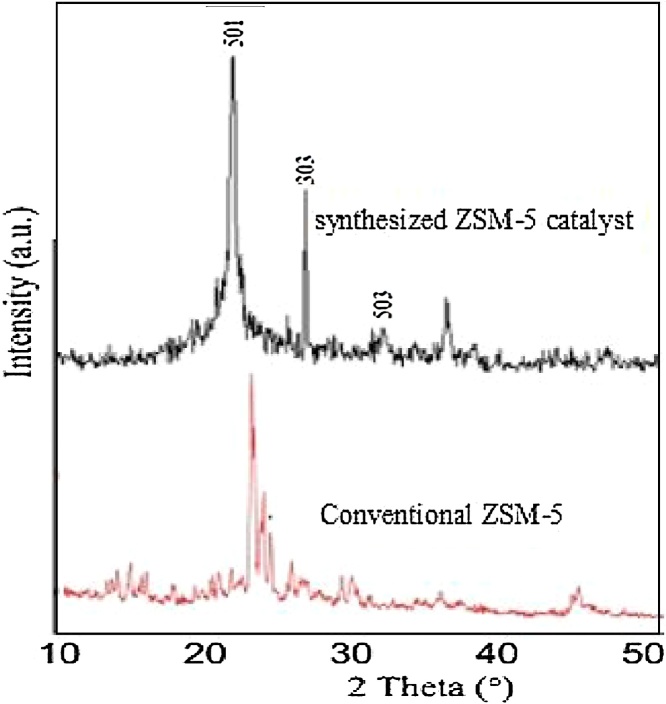
Comparison between Conventional ZSM-5 [8] and synthesized ZSM-5 catalyst XRD patterns.